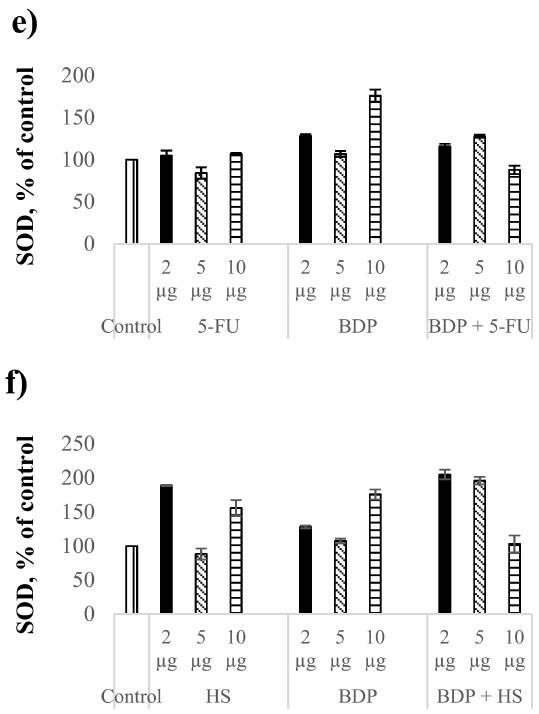
Figure 2. Biochemical indexes under the action of cytostatics and combination drugs at the doses of 2, 5, and 10 µ g · mL − 1 : MDA level in plasma ( a , b ) and erythrocytes ( c , d ), superoxide dismutase activity ( e , f ) as % of control. Biochemical indexes values are taken as 100%: malonic dialdehyde